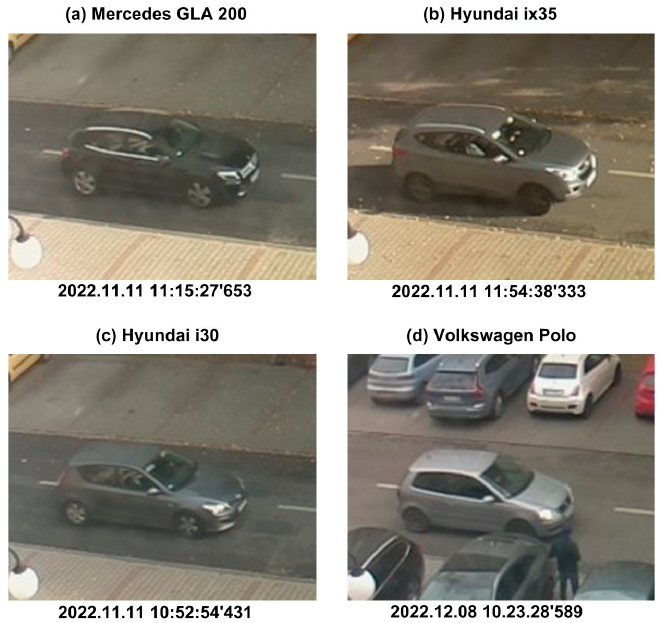
Figure A4. Photographs of the test cars used in experiments, along with the registration timestamp. Table A1. Measurement data for Hyundai i30 test car.